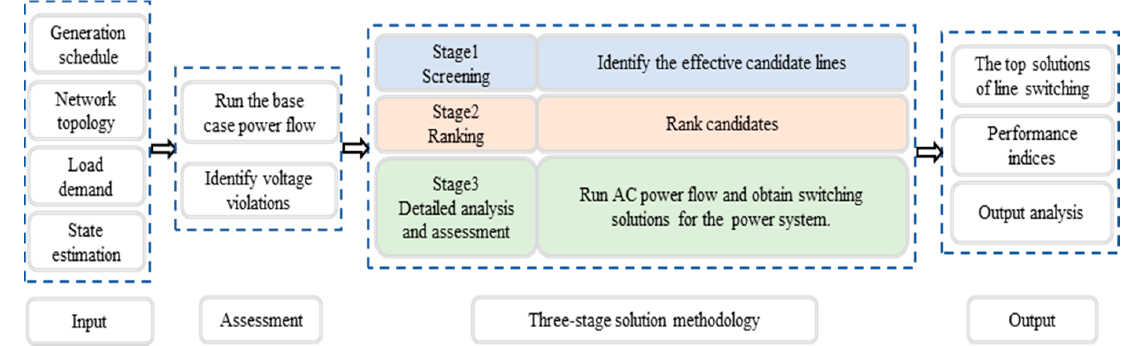
Figure 1. Architecture of the proposed three-stage solution methodology.